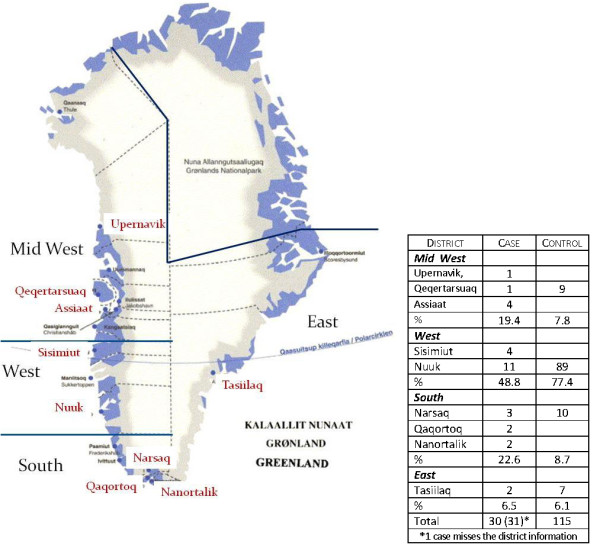
Geographical distribution of the breast cancer cases and controls.